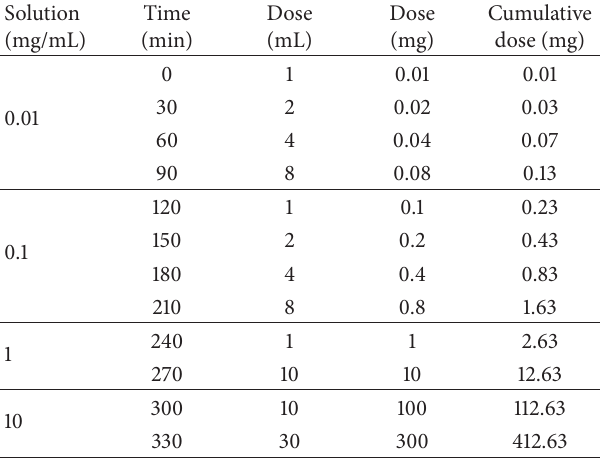
Table 1: Desensitization protocol for